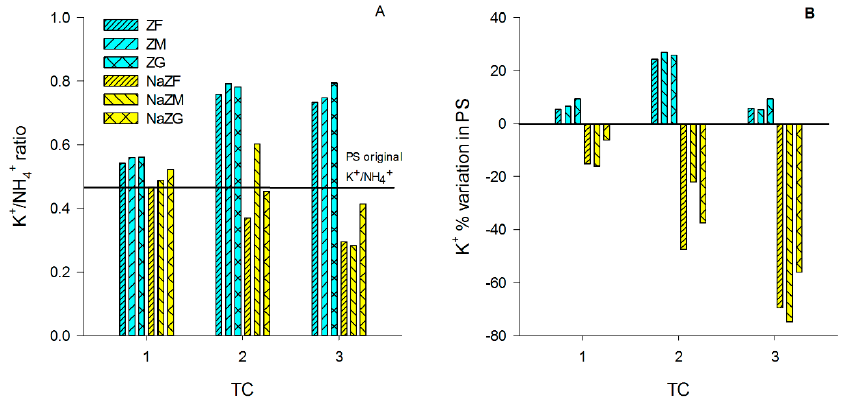
Figure 3. ( A ) K + / NH 4 + ratio variation among treatment cycles (TC) in all the tested samples, treated with natural ZTs in three grain sizes (ZF = grain size 0.1–0.7 mm, ZM = grain size 0.7–2.0 mm and ZG = grain size 2.0–5.0 mm) and Na-homoionic NaZTs in three grain sizes (NaZF = grain size 0.1–0.7 mm, NaZM = grain size 0.7–2.0 mm, and NaZG = grain size 2.0–5.0 mm; ( B ) % of K + variation with respect to the initial values in the pig-slurry among the TCs in all the samples treated with natural and NaZTs.